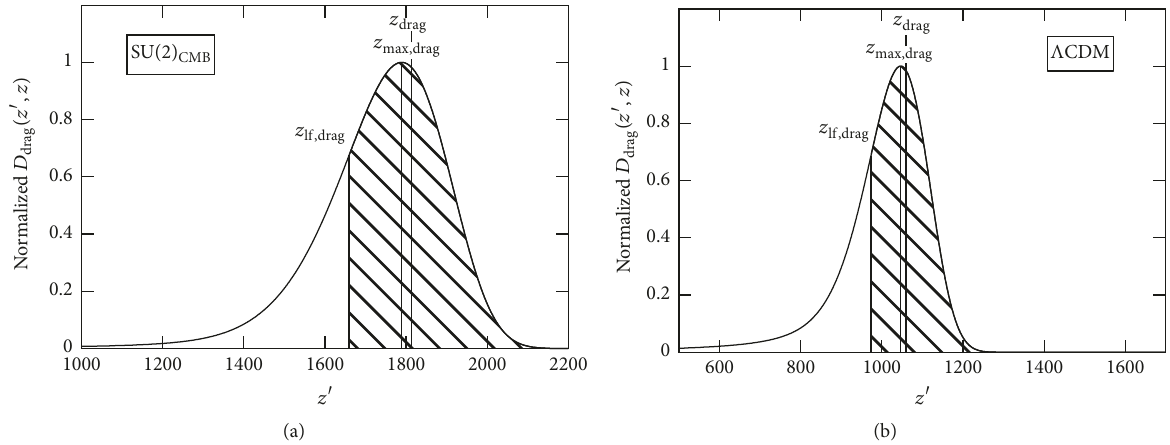
(𝑧 󸀠 ,𝑧) , defined in (14), if 𝑧 ≤ 𝑧 for SU (2) (a) and Λ CDM (b). Redshift 𝑧 drag max , drag CMB / d 𝑧 󸀠 (position of left flank of 𝐷 ) whereas 𝑧 denotes the position of the maximum of 𝐷 drag drag max , drag = 1813 ∼ 𝑧 = 1789 for SU (2) : 𝑧 max , drag drag max , drag = 1659 for SU (2) = 973 for Λ CDM. The hatched area under the curve and 𝑧 lf , drag CMB lf , drag